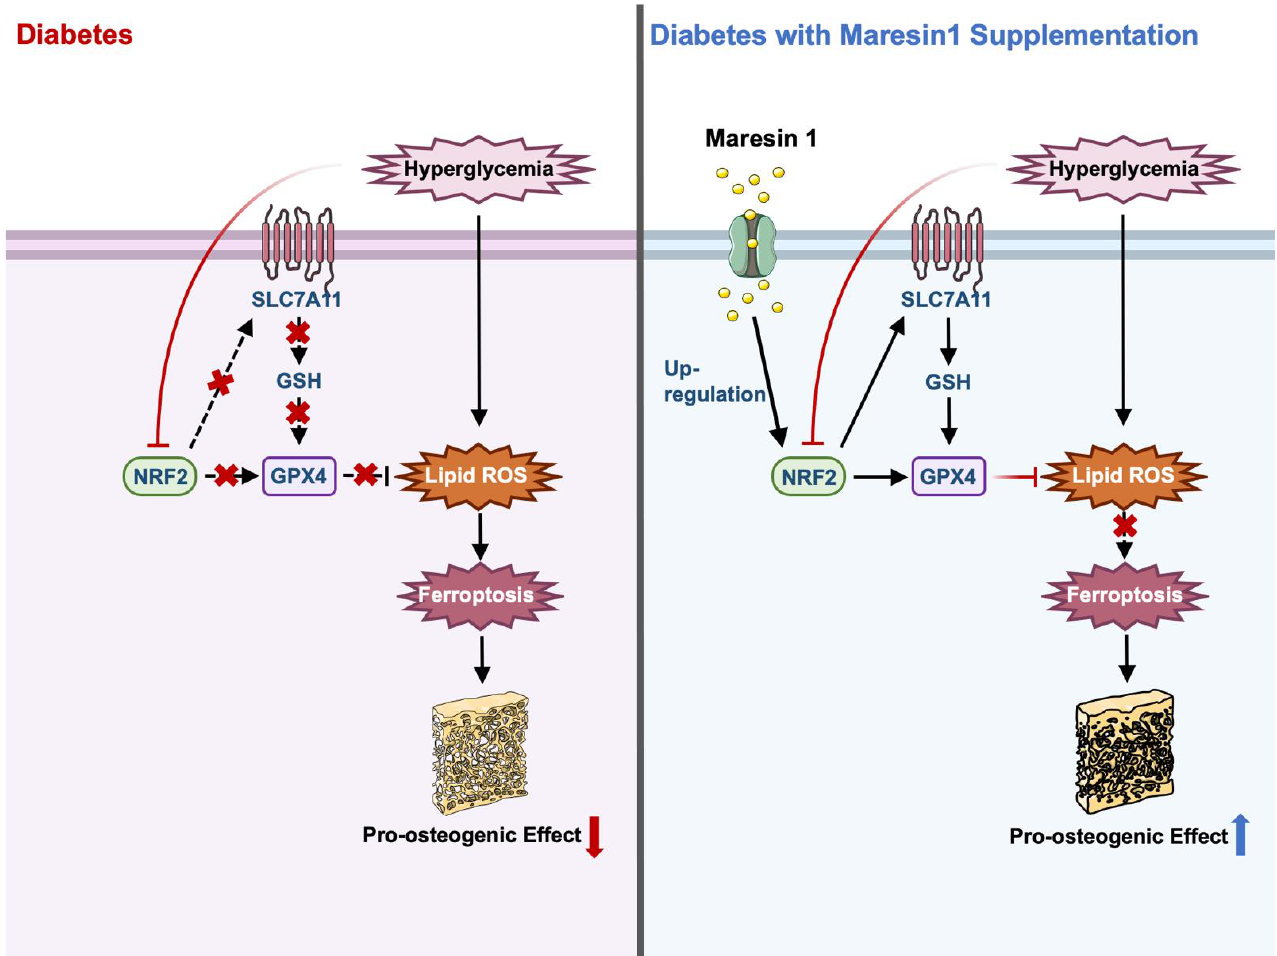
Figure A9. MaR1 improves the osteogenic effect in type 2 diabetic osteoporosis by activating the NRF pathway and inhibiting high-glucose-induced ferroptosis in osteoblasts. In the condition of diabetes, high glucose levels inhibit the activation and translocation of NRF2 to the nucleus so that the downstream factor SLC7A11/GPX4 does not play its antioxidant role well, and cell membrane lipid peroxidation occurs at high rates, resulting in cell ferroptosis, and the osteogenic effect is significantly reduced. Under conditions of diabetes and supply of MaR1, the NRF pathway is activated, nuclear translocation occurs, the expression of SLC7A11/GPX4 is up-regulated, and lipid peroxidation is inhibited. As a result, cell ferroptosis is inhibited, osteogenic capacity is enhanced, and type 2 diabetic osteoporosis is improved. The figure was partly generated using Servier Medical Art, provided by Servier, licensed under a Creative Commons Attribution 3.0 unported license. NRF2: nuclear factor erythroid-2 related factor 2; SLC7A11: cystine-glutamate antiporter; GSH: glutathione; GPX4: glutathione peroxidase 4; Lipid ROS: lipid reactive oxygen species.